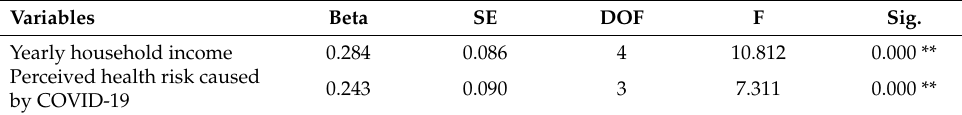
Table 7. Coefficients of Model 6.